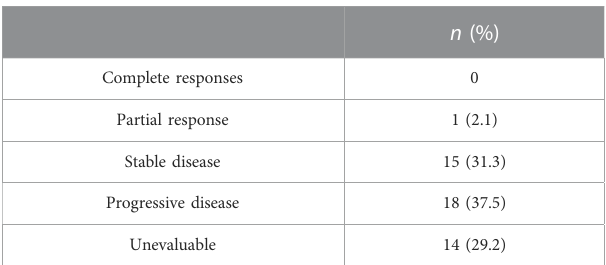
TABLE 3 Disease response